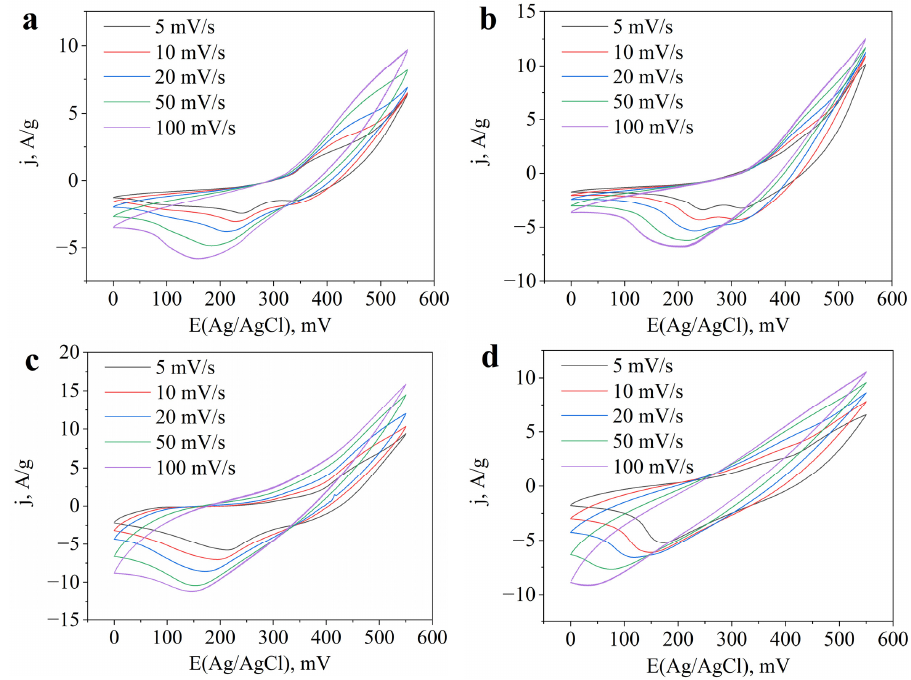
Figure 8. Cyclic voltammetry curves at the different sweep rates for ( a ) Ni(OH) 2 -pure; ( b ) Ni(OH) 2 - PVP; ( c ) Ni(OH) 2 -PVP-Co-elchem; ( d ) Ni(OH) 2 -PVP-Co-chem. For a semi-quantitative comparison of the transport properties of the formed elec- trodes, the dependencies between the cathodic current peaks versus the root of the sweep rates were plotted—Figure 9. Many researchers used these dependencies and the Randles–Sevcik equation for the diffusion of the proton estimation—Equation (10) [53– 56].